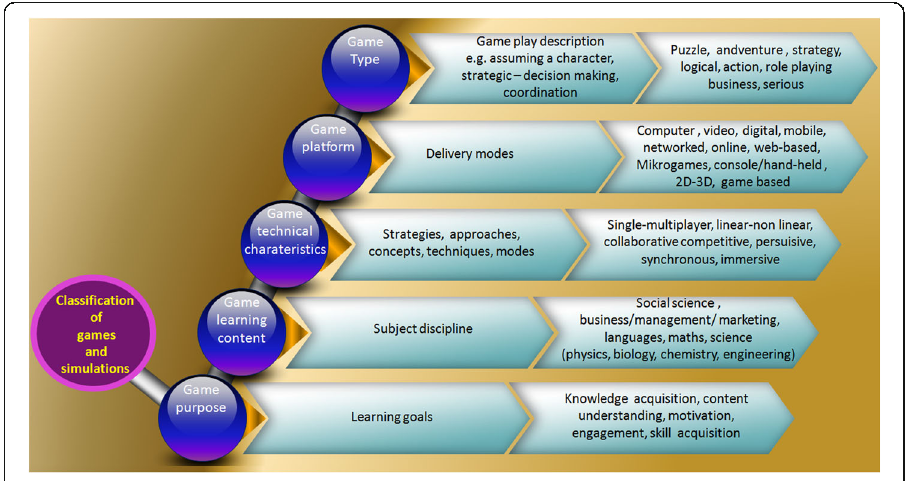
Fig. 1 Classification of games and